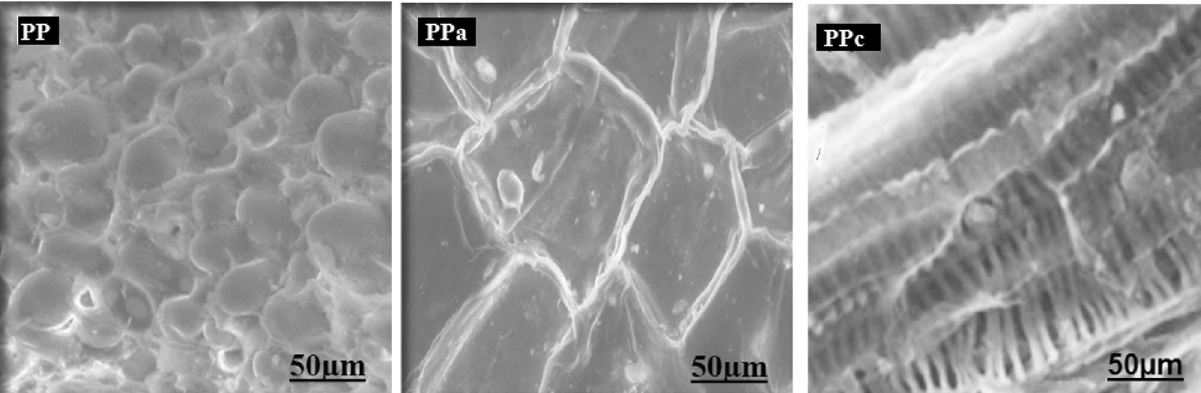
Figure 3. Scanning electron microscopy SEM micrographs of the native, activated and calcined material before treatment.